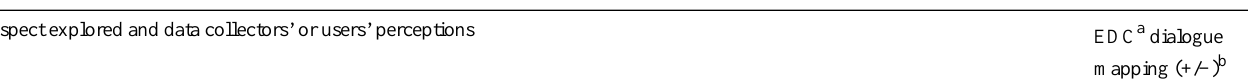
Table 4. Data recorders’perceptions and its isometric dialogue mapping for data capture tools used during a demographic survey site in 2016, in Dabat, northwest